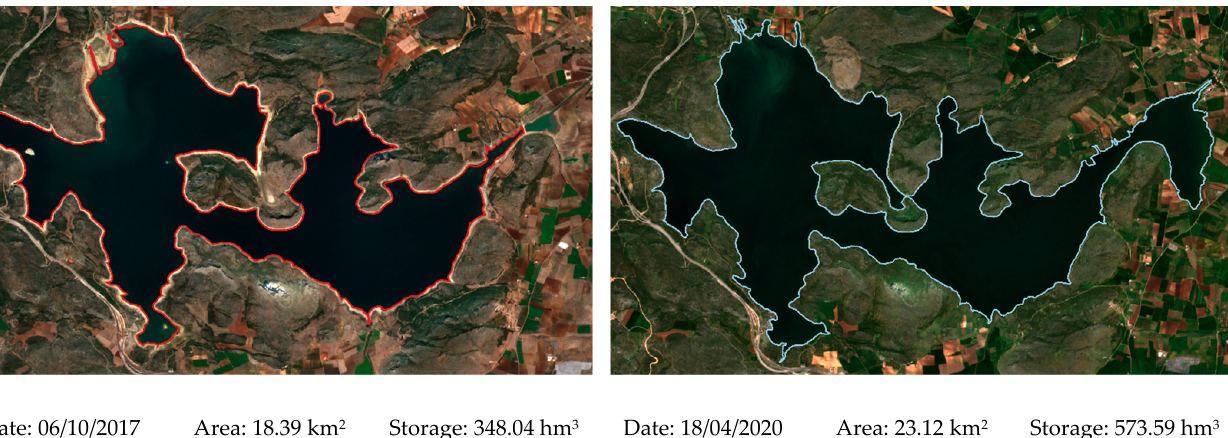
Figure 4. Indicative reservoir snapshots with water perimeter noted with red and cyan color on left and right image, respectively.